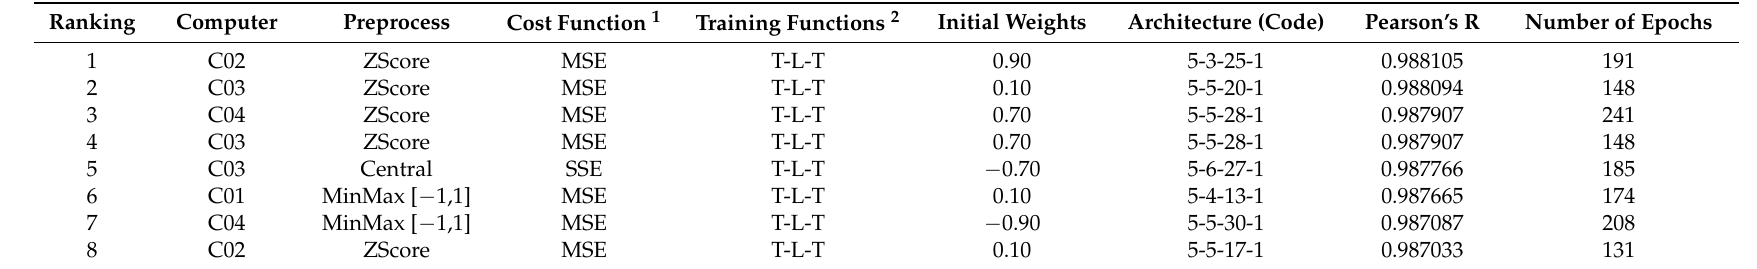
Table 4. Ranking of the top twenty best architectures of BPNNs (Modulus of